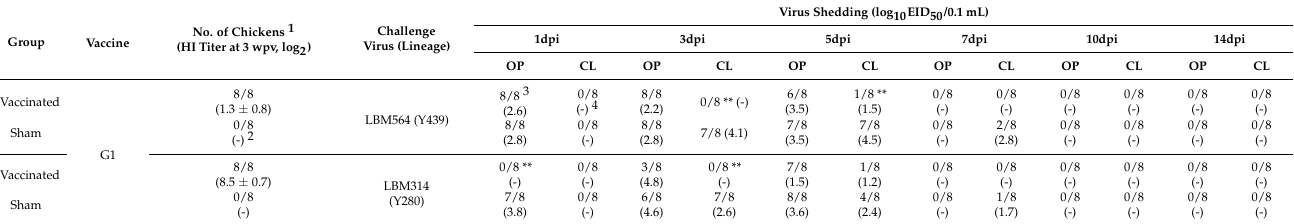
Table 5. Virus shedding by vaccinated SPF chickens challenged with Y439 and Y280 lineage H9N2 viruses (G1).